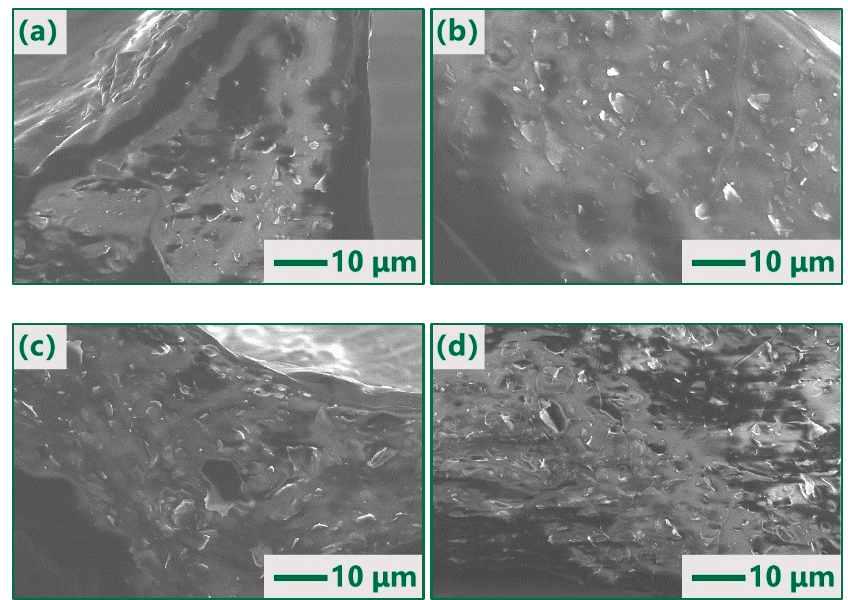
Figure 2. Morphology of SR/Gr composites (foaming expansion rate = 4) containing different